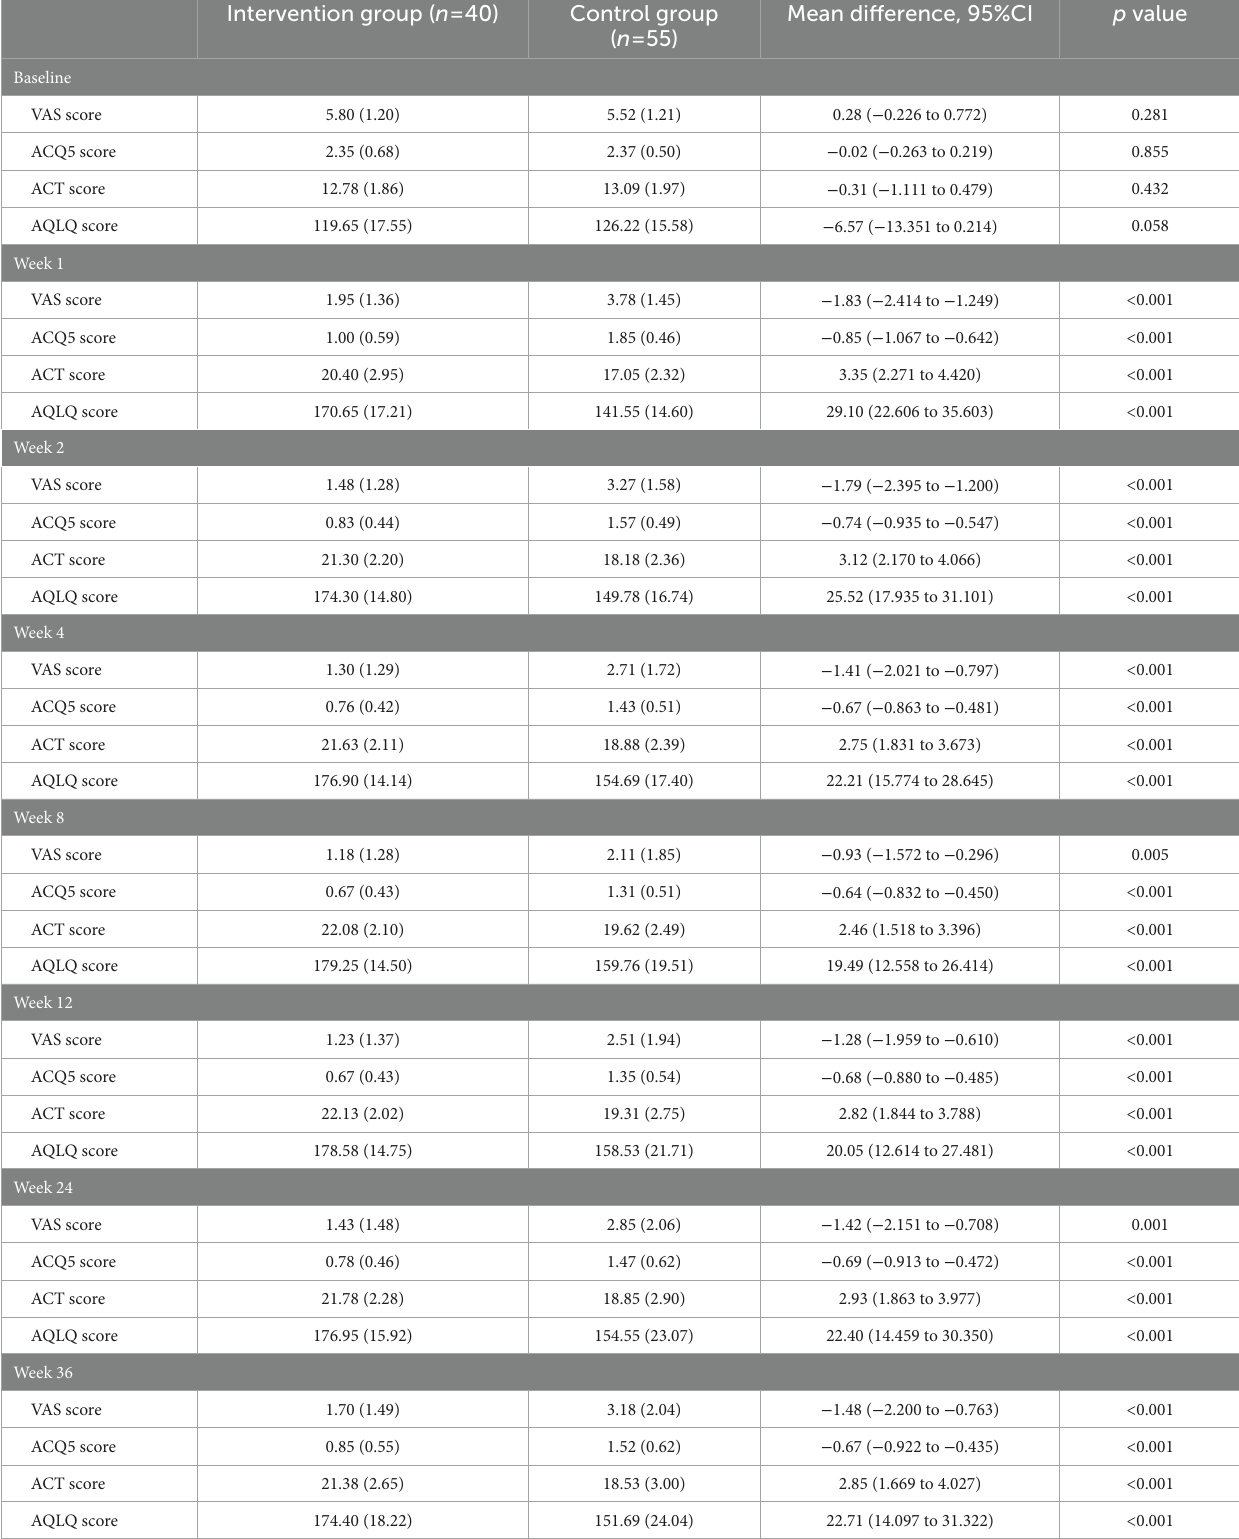
TABLE 3 The differences between groups in change from baseline to 36 weeks in outcomes. Intervention group ( n = 40) Control group Mean difference, 95%CI p ( n = 55)